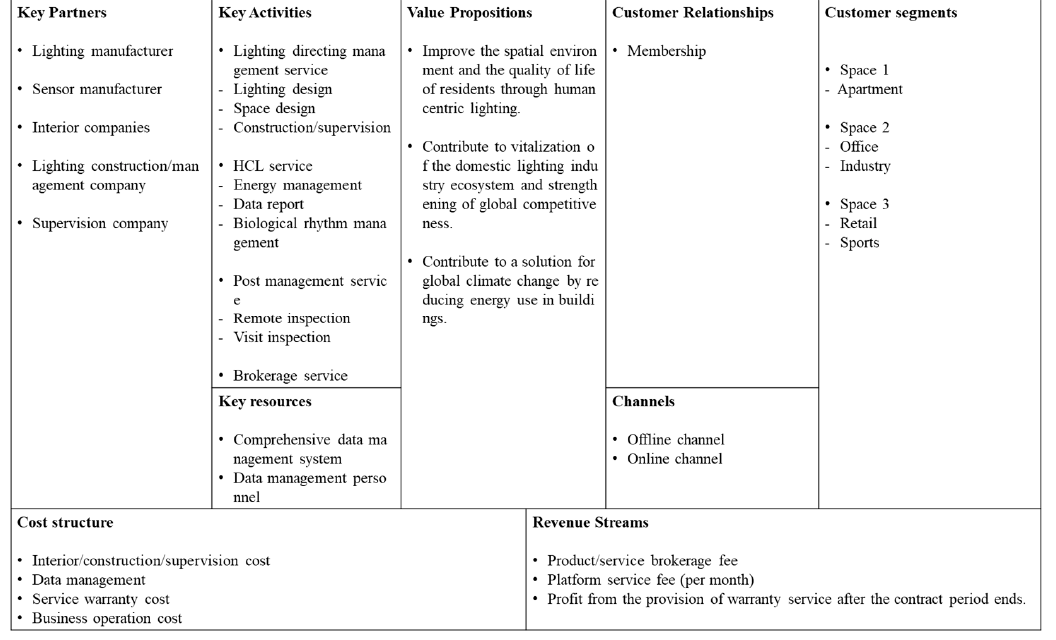
Figure 6. HCL BMC.